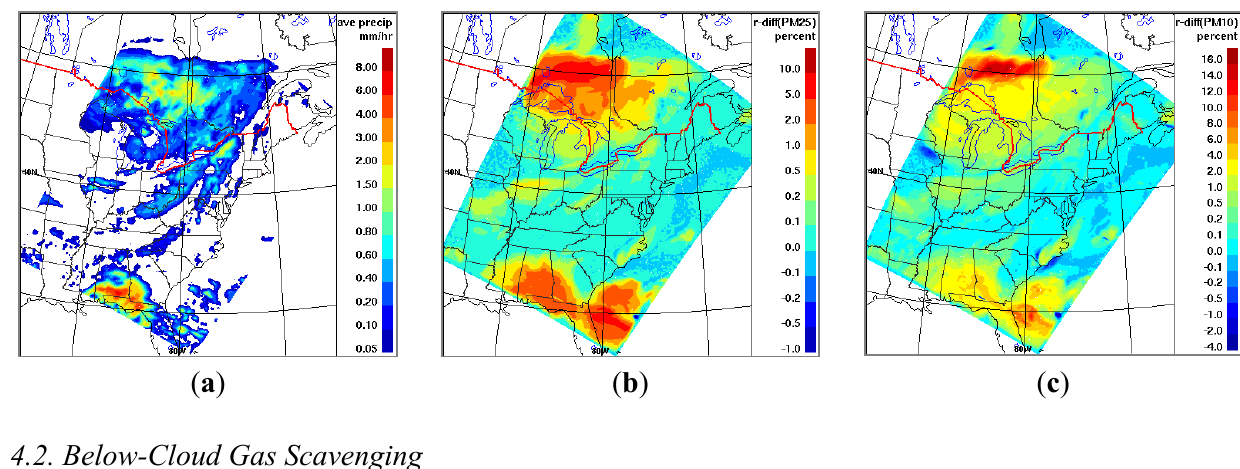
Figure 5 : Modeled daily mean precipitation ( a ) and percentage difference in PM PM ( c ) mass concentrations from using two different scavenging schemes, Androche (A) 10 and Mircea (M), for 10 August 2004. The percentage differences are calculated as ((M − A)/A) ×